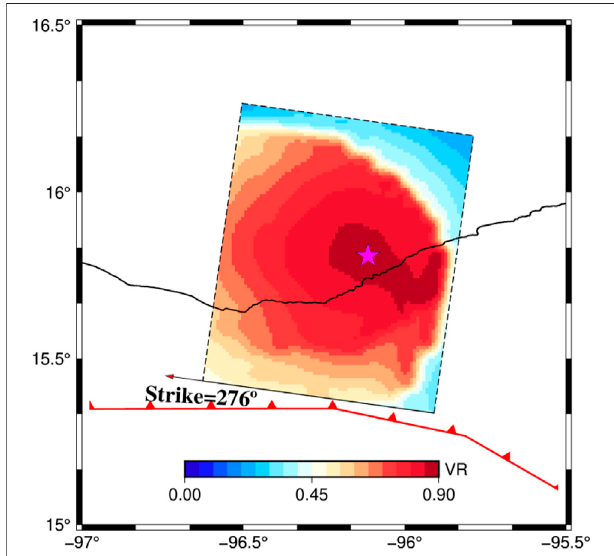
FIGURE5| TotalVRwiththemodelparametersinjointinversionateach grid on the fault plane; the magenta star denotes the hypocenter location corresponding to the maximum